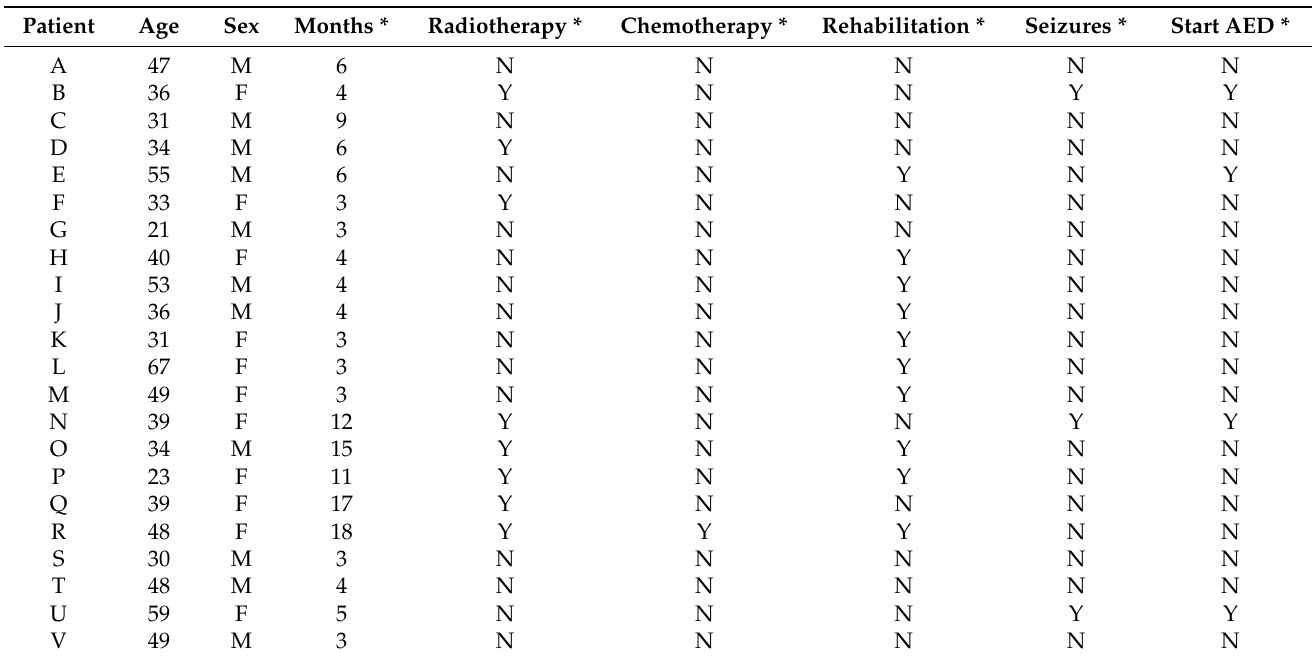
Table 1. Patients’ characteristics.